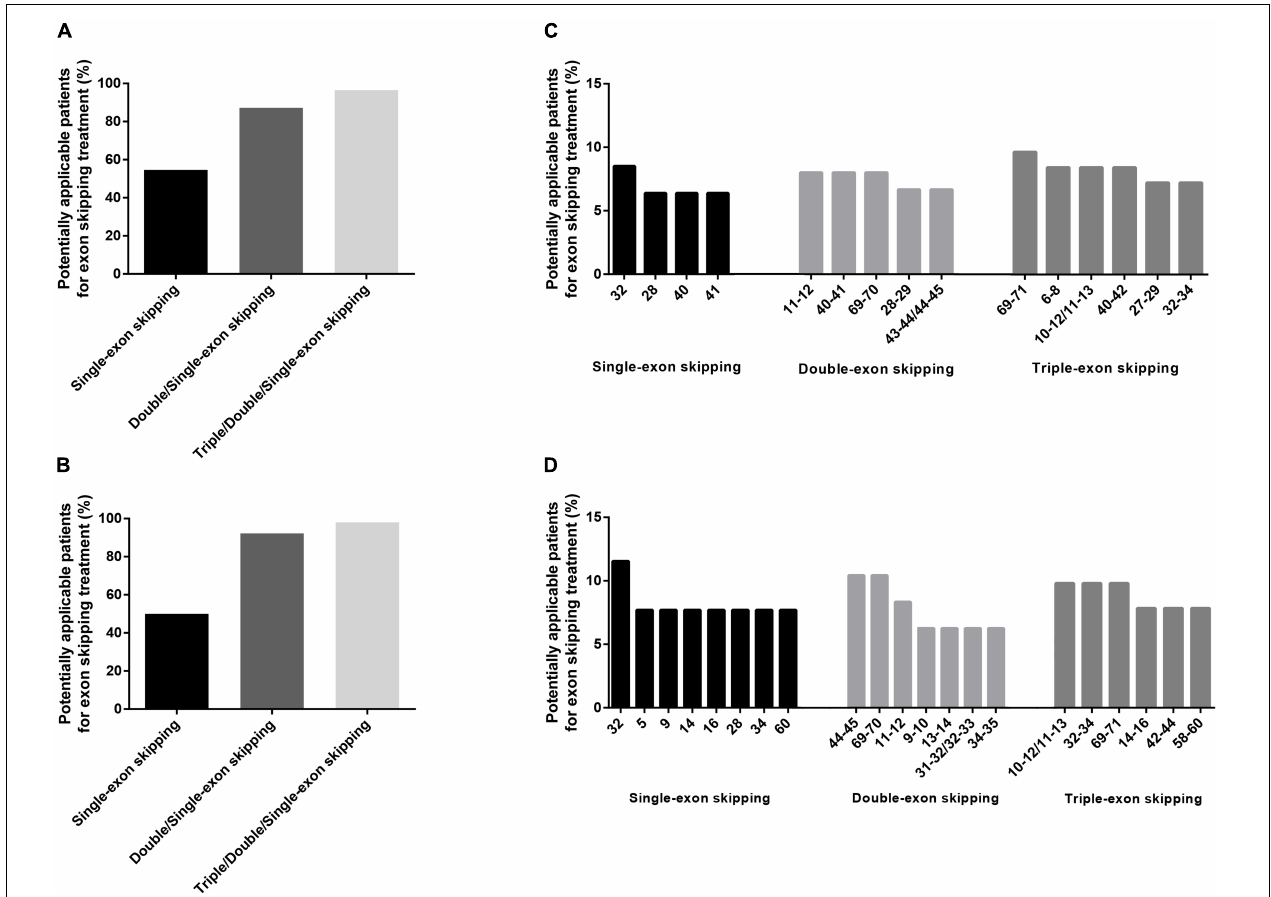
FIGURE 10 | Exon skipping strategies for truncating and missense mutations. The covering proportions of potentially applicable patients among (A) all patients, and (B) those with Duchenne muscular dystrophy (DMD)/intermediate muscular dystrophy (IMD). Exon skipping strategies for (C) all patients and (D) those with